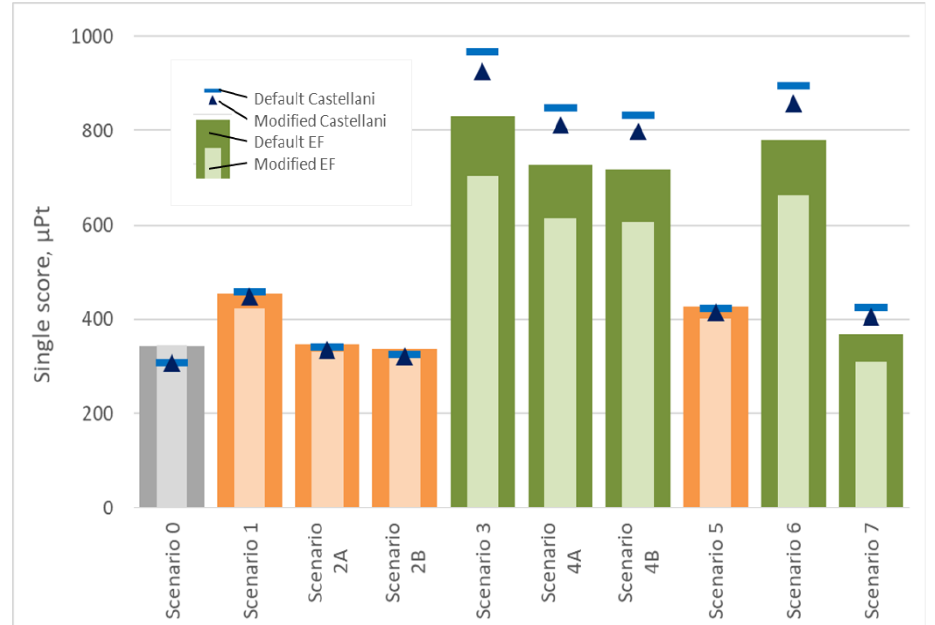
Figure 5. The aggregate environmental impact of polyester and its bio-based substitutes. The re- sults refer to single scores obtained with Default EF method.